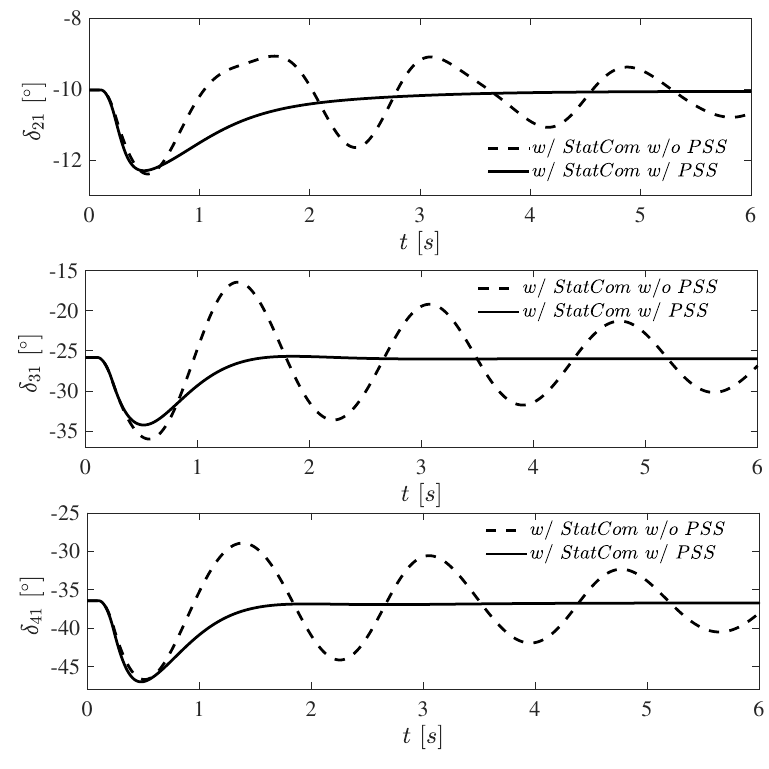
Figure 6. Angular difference of each machine with respect to number one, case 1: 8 cycles until the fault is